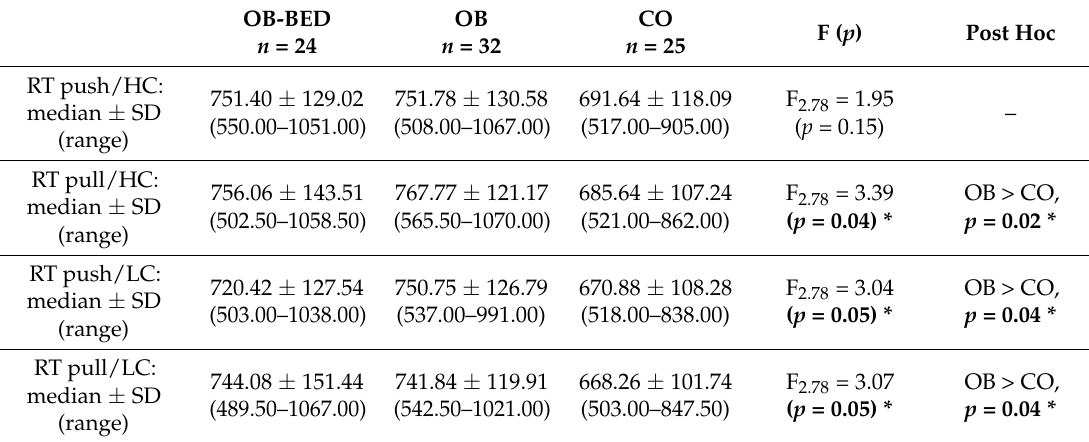
Table 5. Median values, standard deviation (SD) and range (minimum – maximum) per condition (push/pull vs. HC/LC) × group for response times (RTs) (in ms). A MANOVA was performed for comparisons between the groups. OB-BED = patients with obesity and current BED, OB = subjects with obesity without BED, CO = norm-weight controls without self-reported lifetime eating disorder diagnosis. HC = high-calorie food picture, LC = low-calorie food picture. OB-BED n =